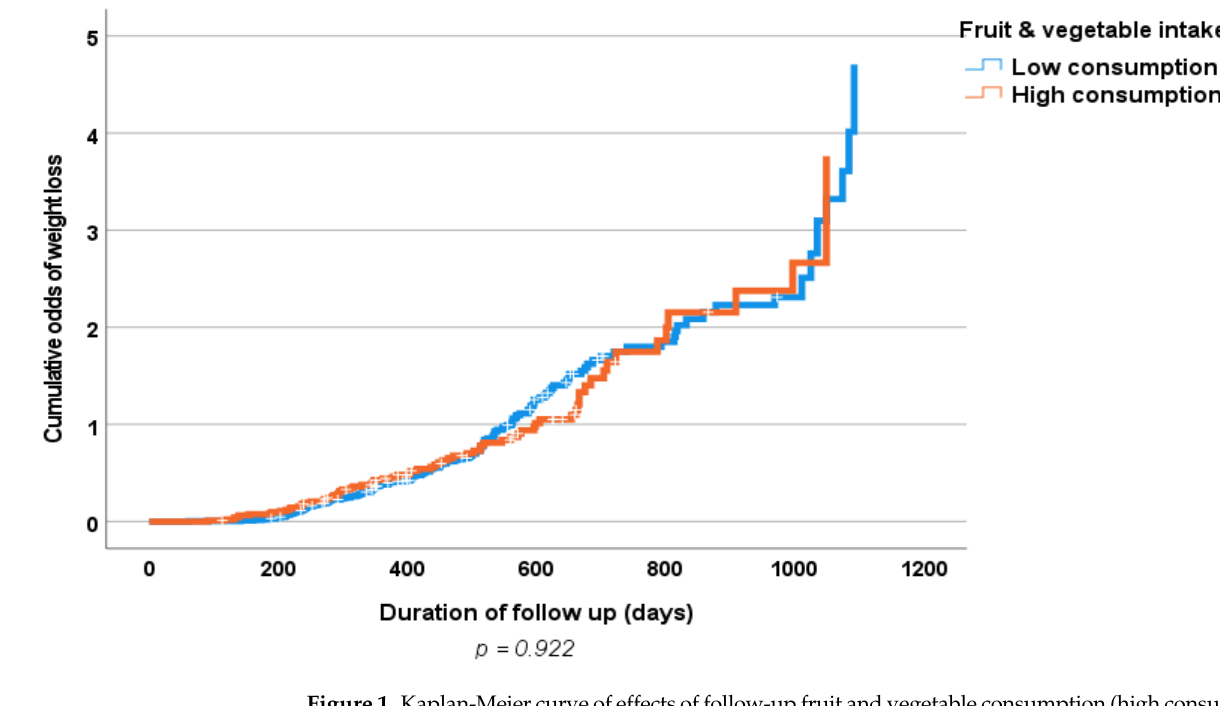
Figure 1. Kaplan-Meier curve of effects of follow-up fruit and vegetable consumption (high consumption > 3.7 servings/day vs. low consumption ≤ 3.7 servings/day) on body weight (loss vs. gain).